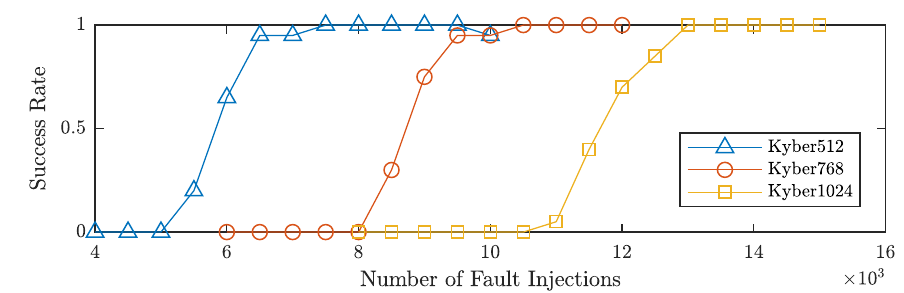
Figure 10: Attack success rate for all 3 Kyber parametrizations as function of faulted decapsulations